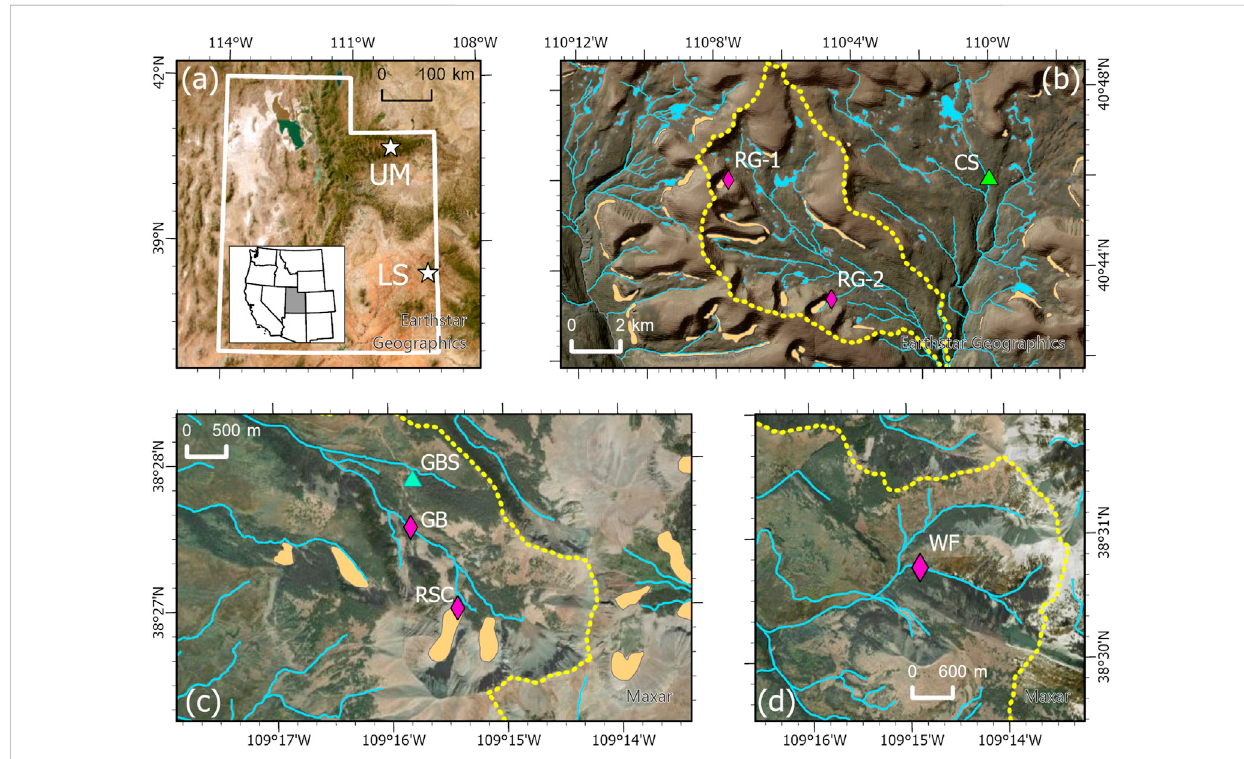
FIGURE 1 (A) Locations of the Uinta Mountains (UM) and the La Sal Mountains (LS) in the state of Utah, United States (white stars). Background is a true color satellite composite from Earthstar Geographics. (B) Map of the study area in the West Fork Whiterocks River drainage in the Uinta Mountains. The watershed boundary is shown by the yellow dashed line. Light orange polygons are mapped rock glaciers. The studied rock glaciers and their associated water samplers (purple diamonds) are labeled, RG-1 and RG-2. The green triangle marks the Chepeta SNOTEL site (CS). Background is a true color satellite composite from Earthstar Geographics. (C) Map of the Gold Basin study area in the La Sal Mountains. The watershed boundary is shown by the yellow dashed line. Light orange polygons are mapped rock glaciers. The water sampler at thetoe of the Red Snow Cirque (RSC) rock glacier is shown by the purple diamond, as is the downstream sampler GB. The green triangle marks the Gold Basin SNOTEL site (GBS). Background is a true color satellite composite from Maxar. (D) Map of the Wet Fork study area in the La Sal Mountains. The watershed boundary is shown by the yellow dashed line. The location of the Wet Fork water sampler (WF) is marked by the purple diamond. There are no rock glaciers in this drainage. Background is a true color satellite composite from